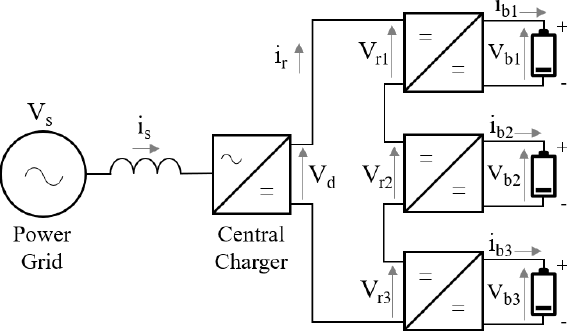
Figure 7. Active battery-based modular charger.